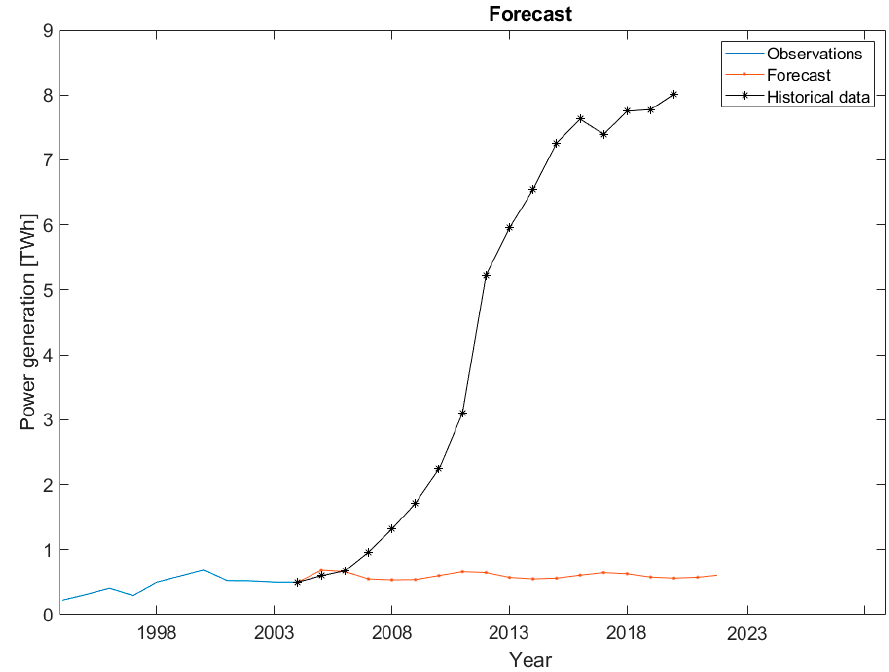
Figure 7. Prediction for renewable energy production without state aid.